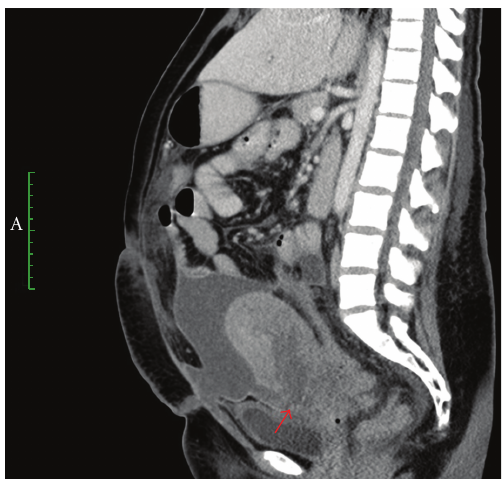
Figure 5: This sagittal CT of the abdomen better demonstrates the dehiscence of the anterior, lower uterus (arrow), and the peritoneal fluid. The endometrial cavity is distended with fluid that is contiguous with the peritoneal space. right middle lobe, compatible with bilateral